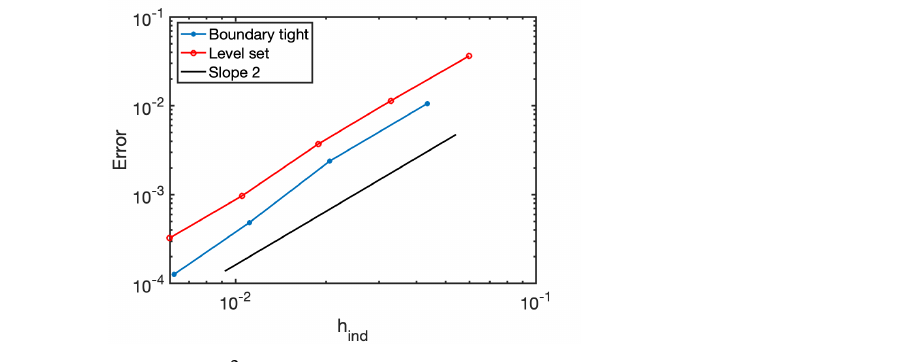
Figure 12. L 2 − error vs. size indicator (logarithmic scale) of the boundary tight and level set approaches.